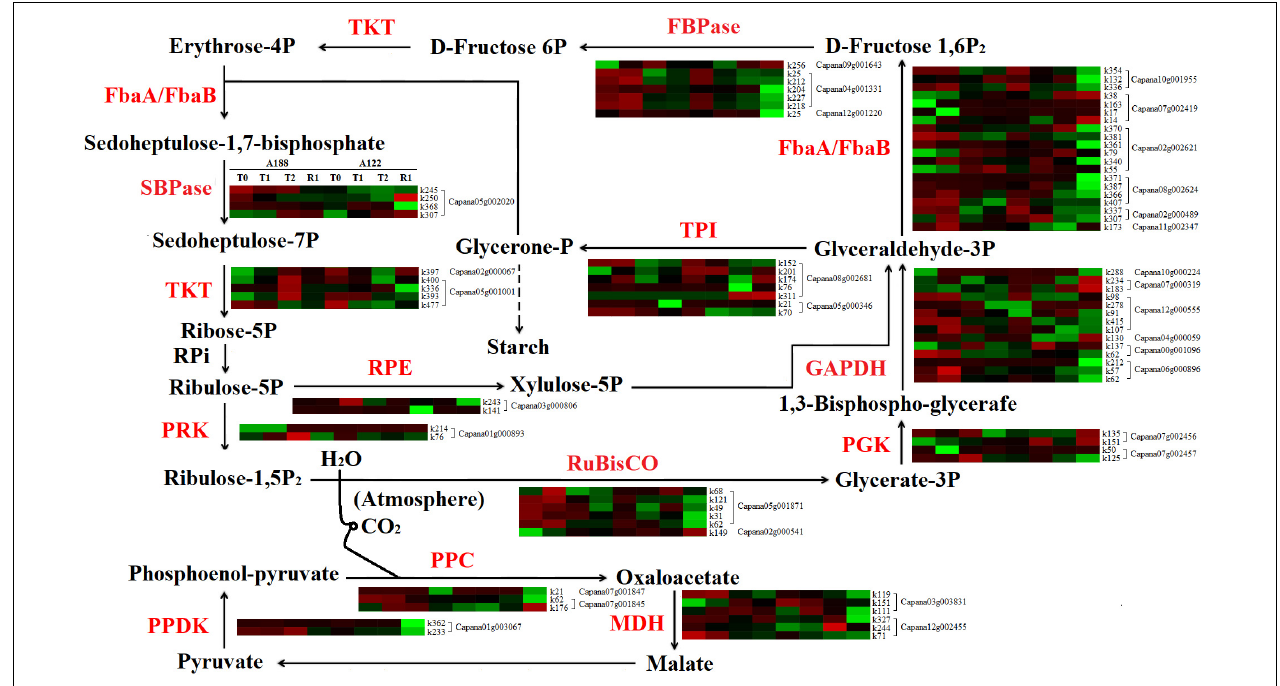
FIGURE 9 | Comparative analysis of acetylated proteins involved in carbon fixation in photosynthetic organisms. FBPase, fructose-1,6-bisphosphatase; TKT, Transketolase; SBPase, sedoheptulose-1,7-bisphosphatase; PRK, phosphoribulokinase; RPE, ribulose-phosphate 3-epimerase; PPDK, pyruvate, phosphate dikinase; TPI, triosephosphate isomerase; GAPDH, glyceraldehyde-3-phosphate dehydrogenase; RuBisco, ribulose bisphosphate carboxylase; PPC, phosphoenolpyruvate carboxylase; MDH, malate dehydrogenase; FbaA/FbaB, fructose-bisphosphate aldolase. PGK, phosphoglycerate